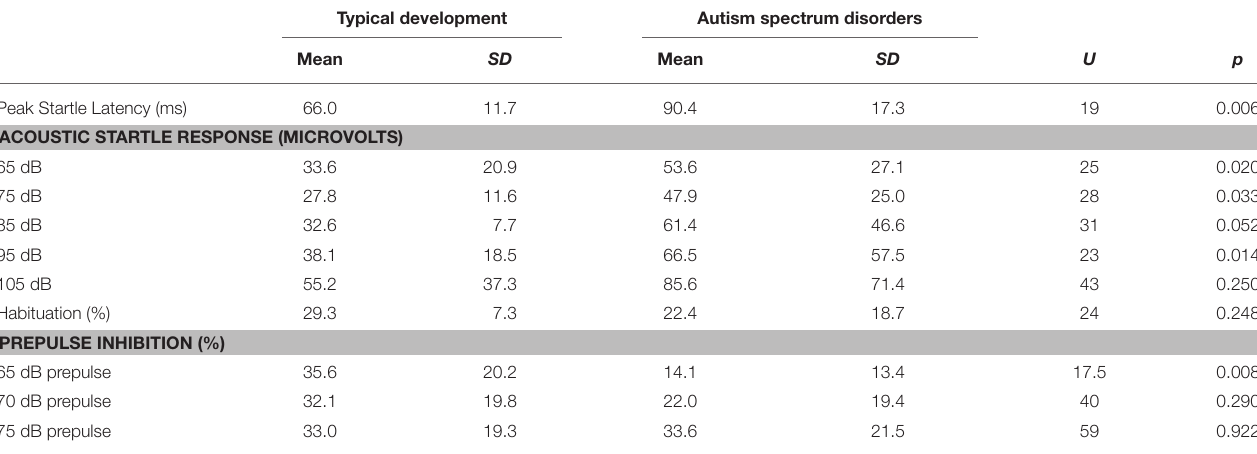
TABLE 1 | Acoustic startle response measures.